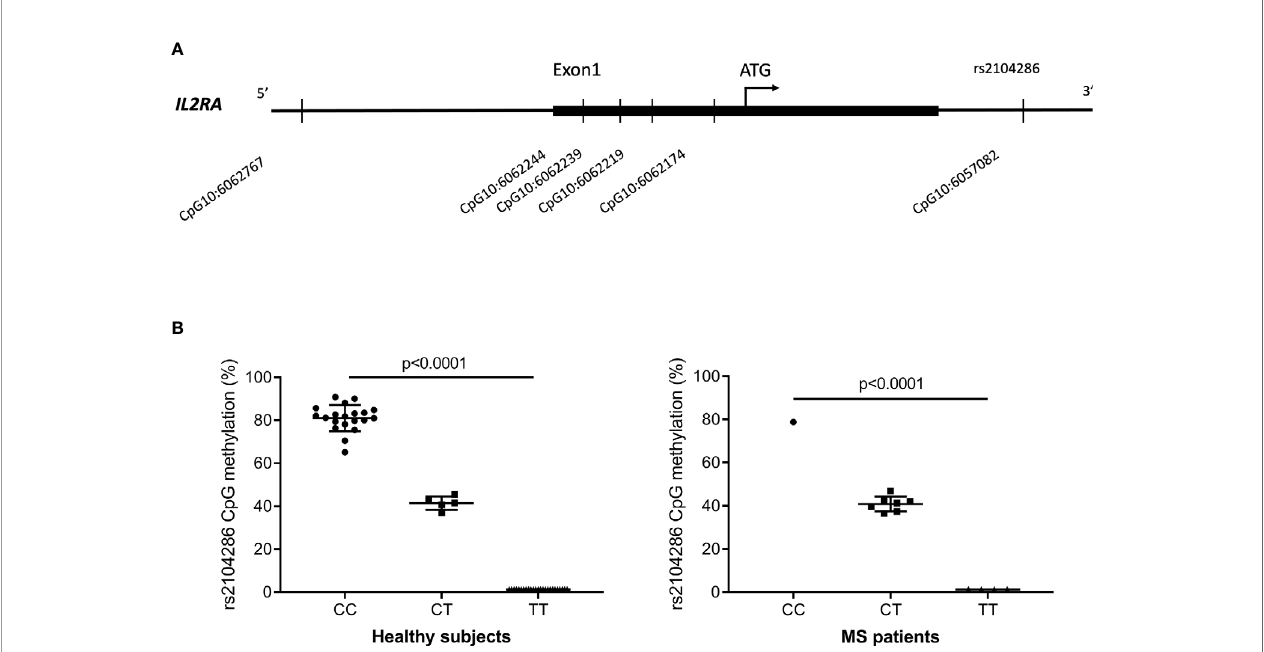
FIGURE 1 | (A) Overview of the 6 CpG-sites in the IL2RA regulatory region and intron 1 that passed quality control and were methylated above background. Four CpG-sites were in the region corresponding to the 5 ’ UTR and 1 CpG-site was located upstream of this in the promotor region. CpG10:6057082 was located in intron 1 at the site of rs2104286. (B) Methylation at the CpG10:6057082 that is perturbed by the MS-associated IL2RA rs2104286 SNP in healthy subjects (CC = 20; CT = 5; TT = 25) and MS patients (CC = 1; CT = 7; TT = 4). Of the 50 HS, 38 were from cohort 1 and 12 were from cohort 2. Data were analysed by one-way analysis of variance. Error-bars represent mean with